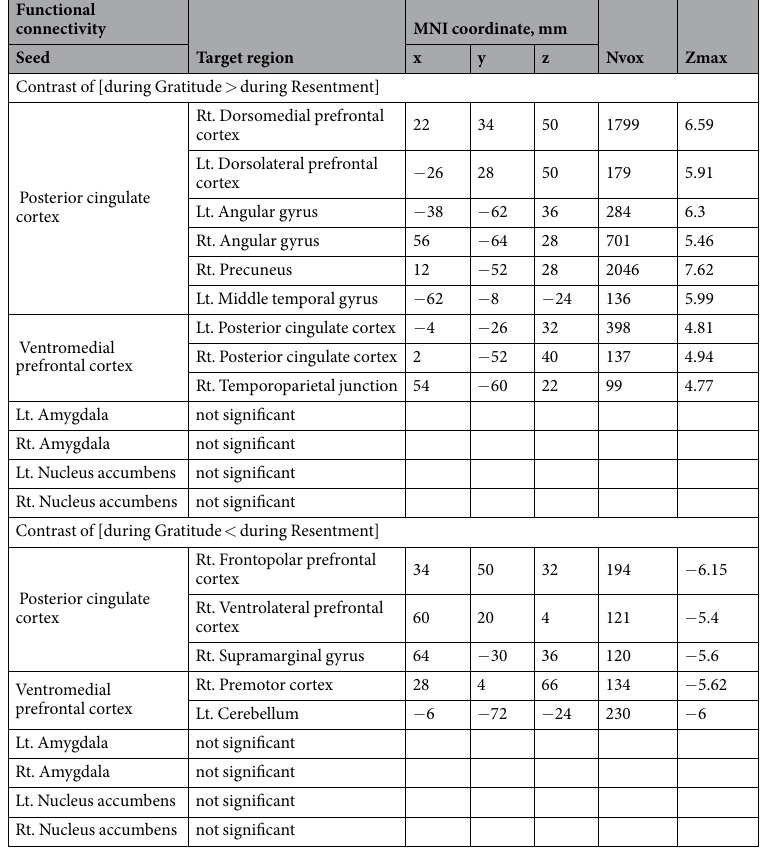
Table 1. Statistical comparisons of seed-based functional connectivity during gratitude and resentment interventions. Significant clusters were obtained at family-wise error rate corrected P < 0.05. Abbreviation: Lt, left; MNI, Montreal Neurological Institute; Nvox, number of contiguous voxels; Rt, right; Zmax, maximum z-value within the